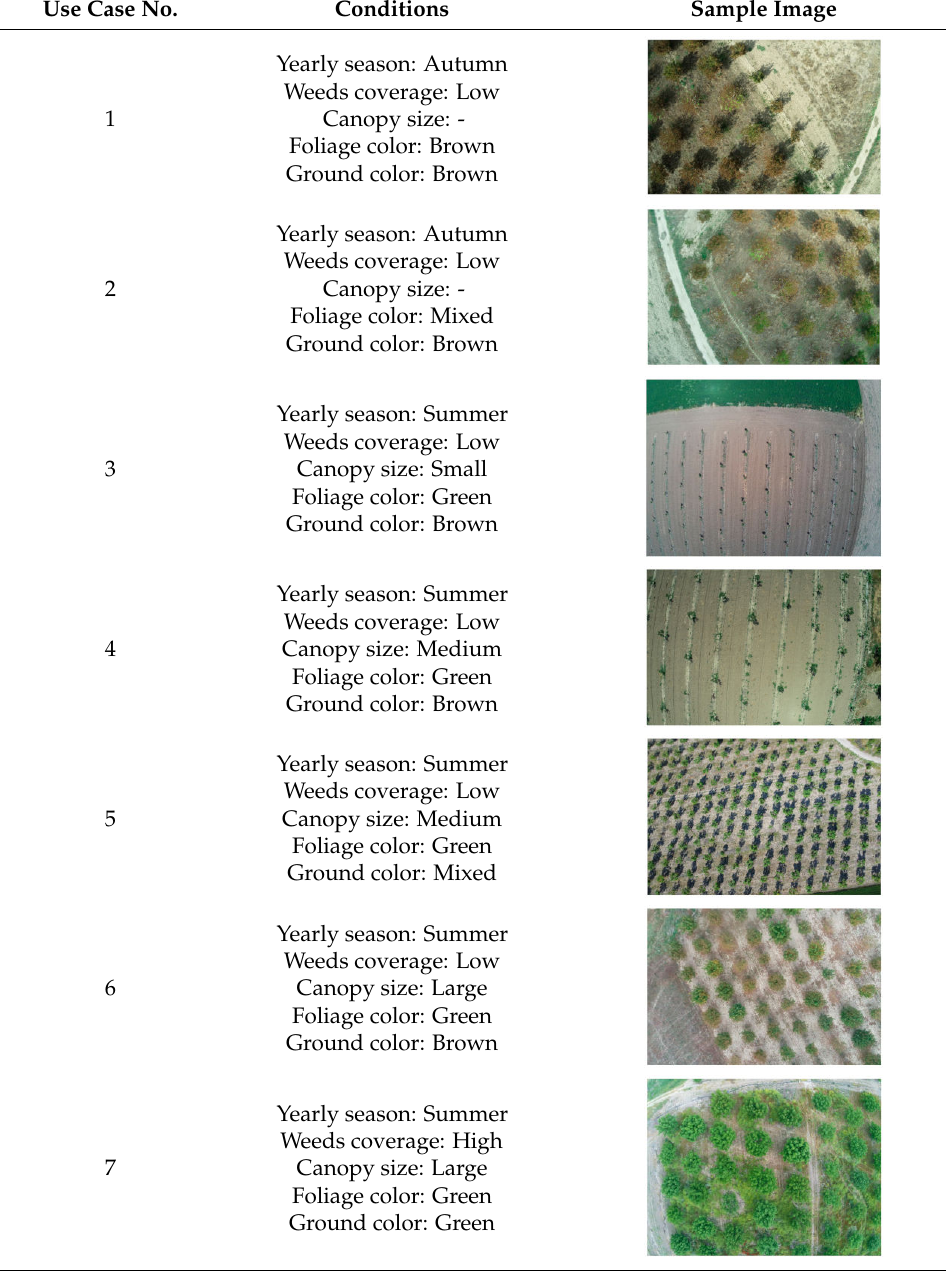
Table A1. Sample images of the seven use cases included in the study. Use Case